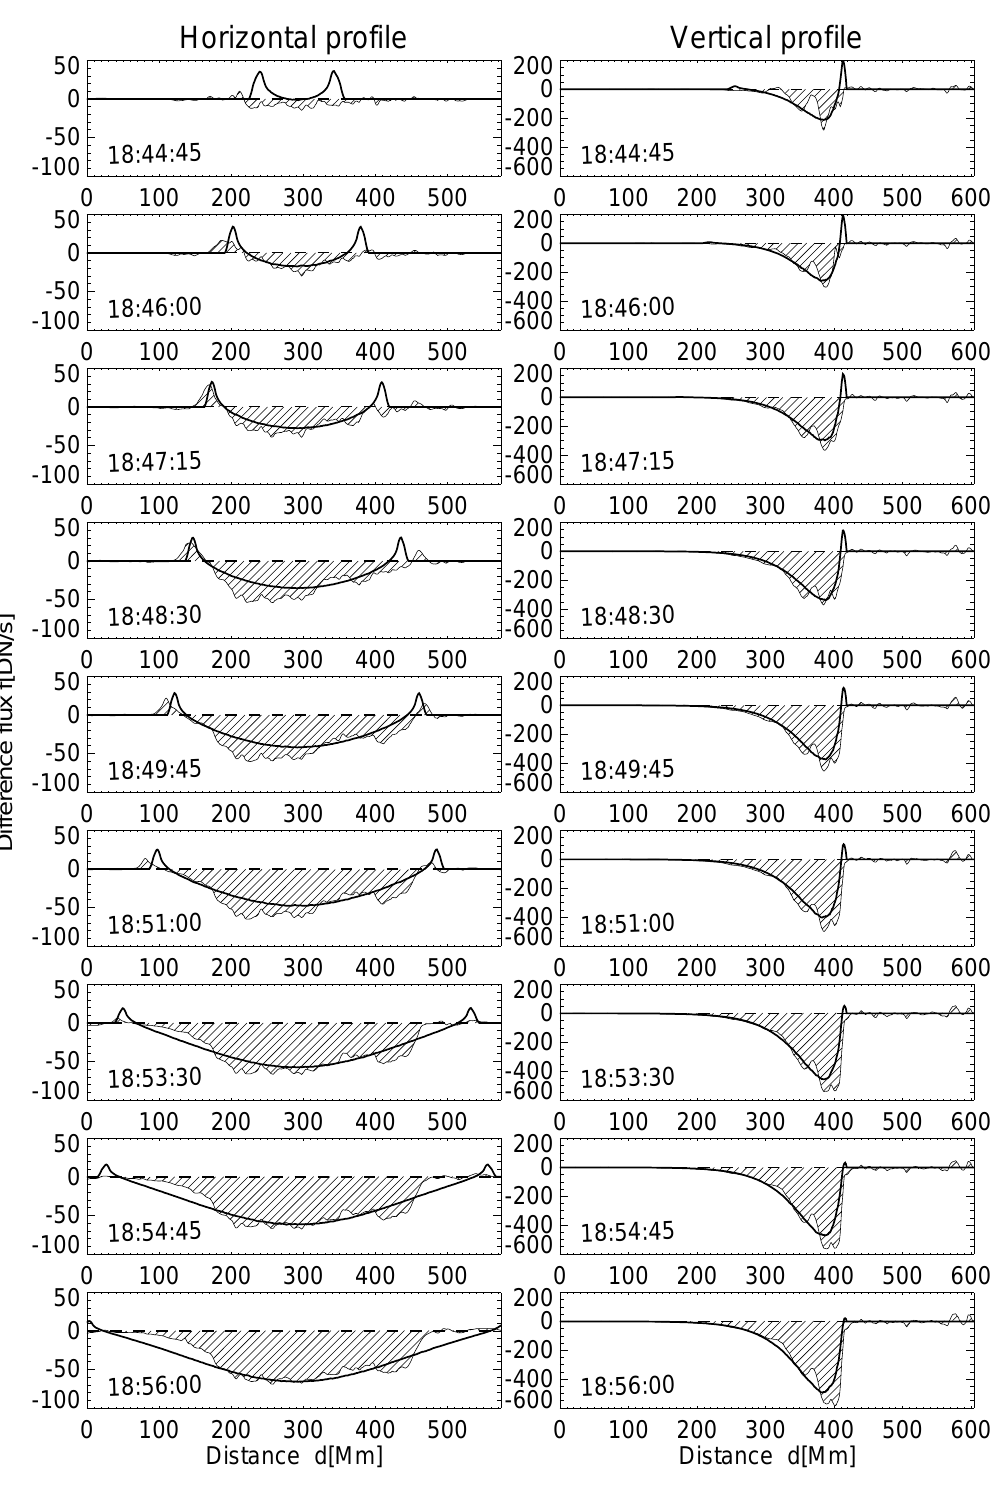
Fig. 5. Cross-sectional (baseline-subtracted) EUV brightness profiles in horizontal direction above the limb (left-hand panels) and in vertical direction through the centroid of the dimming region (right-hand panels), as marked with dashed lines in Fig. 2, for the 9 images during 18:44:56–18:56:00UT, for EUVI/A, 171 ˚A. The observed dimming is represented with hatched areas, while the best-fit model profiles are plotted with thick